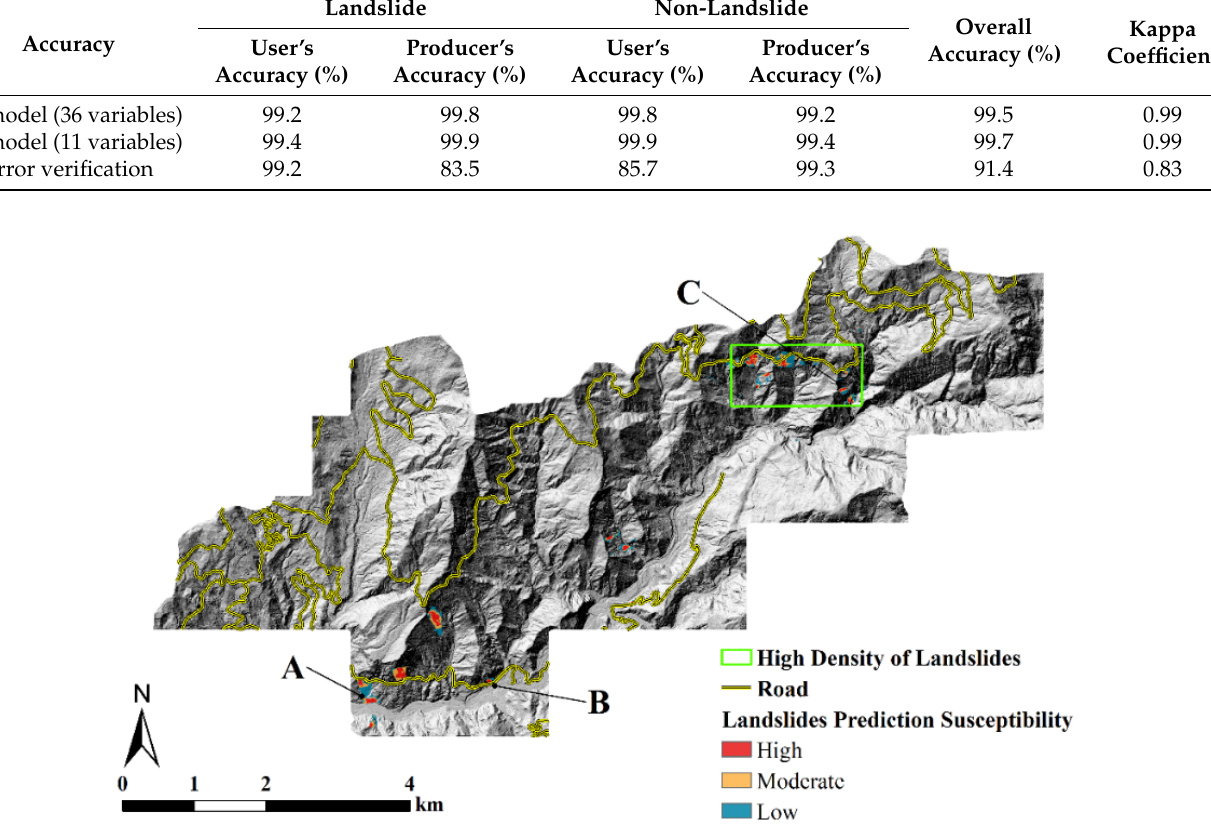
Figure 4. Spatial distributions of predicted susceptibility landslide areas in the study region. The enlarged sites and a green rectangle region were chosen to illustrate high density landslides in steep slope areas.